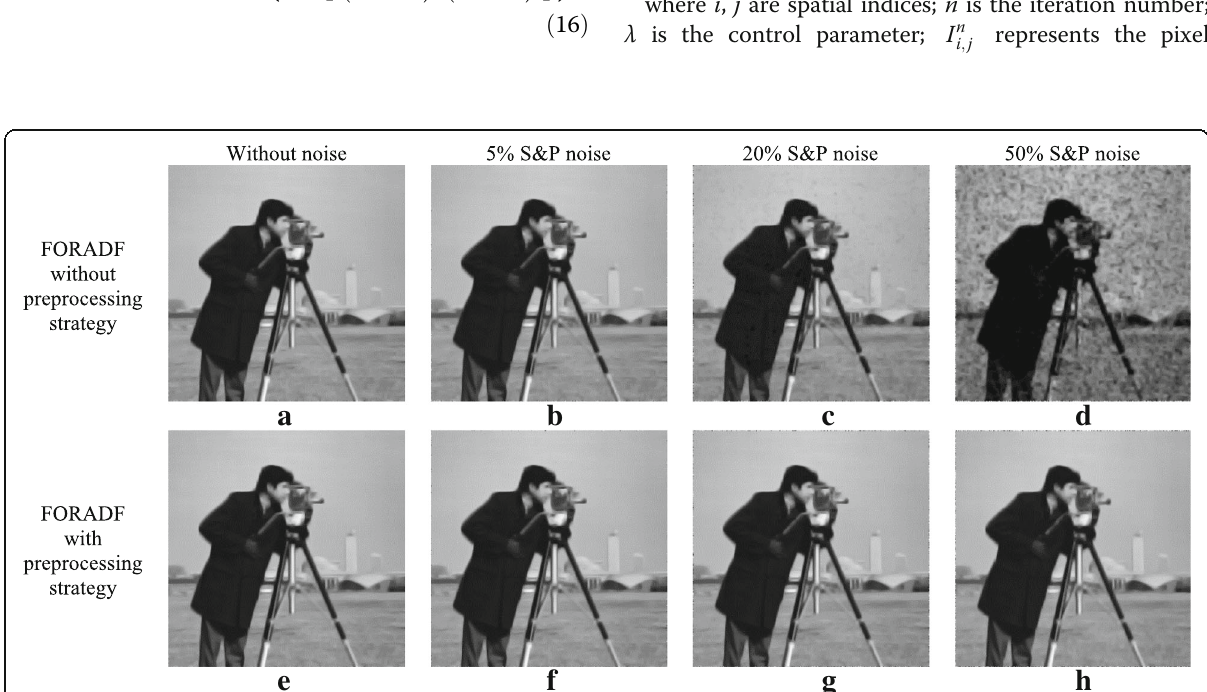
Fig. 7 Performance of FORADF ( λ = 1, n = 10) with and without preprocessing strategy. Without preprocessing strategy: a without noise, b - d 5%, 20%, and 50% salt and pepper noise respectively. With preprocessing strategy: e without noise, f - h 5%, 20%, and 50% salt and pepper noise respectively. λ represents the control parameter, and n represents the number of iterations